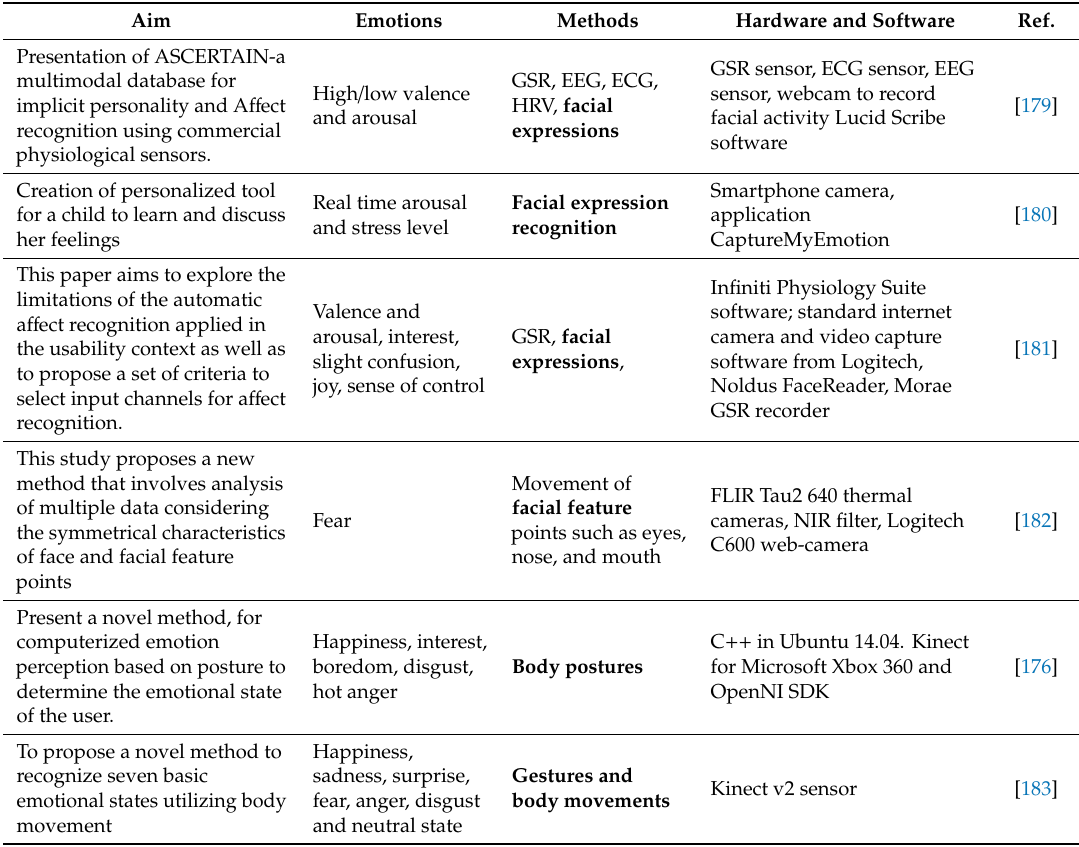
Table 13. Review of scientific researches focused on emotions recognition and evaluation using analysis of facial expressions, body posture and gestures. Aim Emotions Methods Hardware and Software